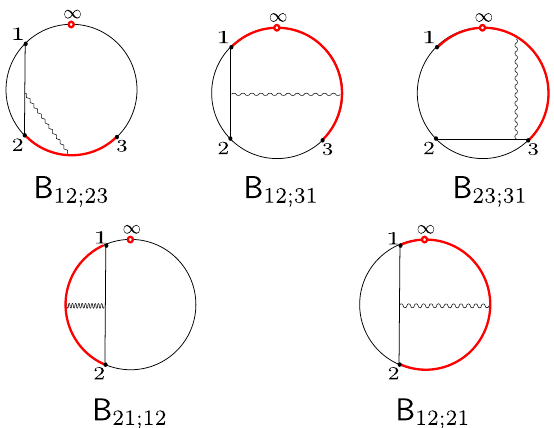
Figure 6 . Boundary diagrams relevant for the three-point functions (the (cid:12)rst row) and the two- point functions (the second row). All these diagrams can be obtained by taking the limit of the (cid:12)gure